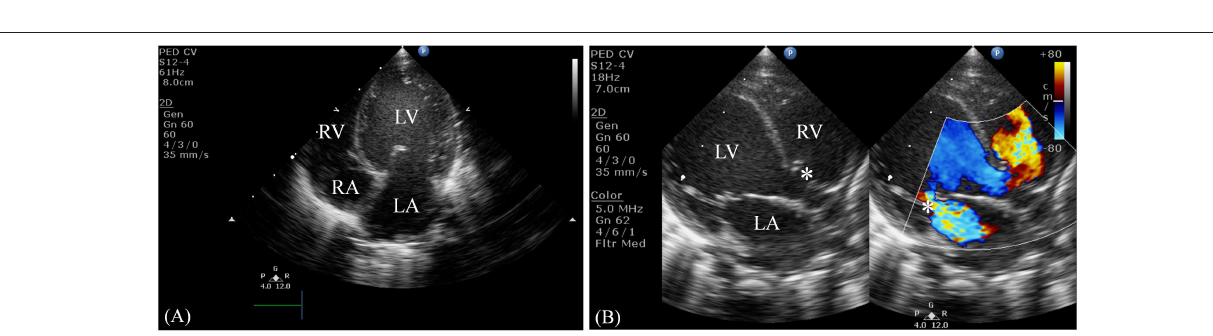
FIGURE 3 | Imaging studies. (A) The chest radiography revealed cardiomegaly and pulmonary congestion. (B) A sagittal view using brain sonography showed a subtle hypoplasia of the corpus callosum (indicated by the white arrow).